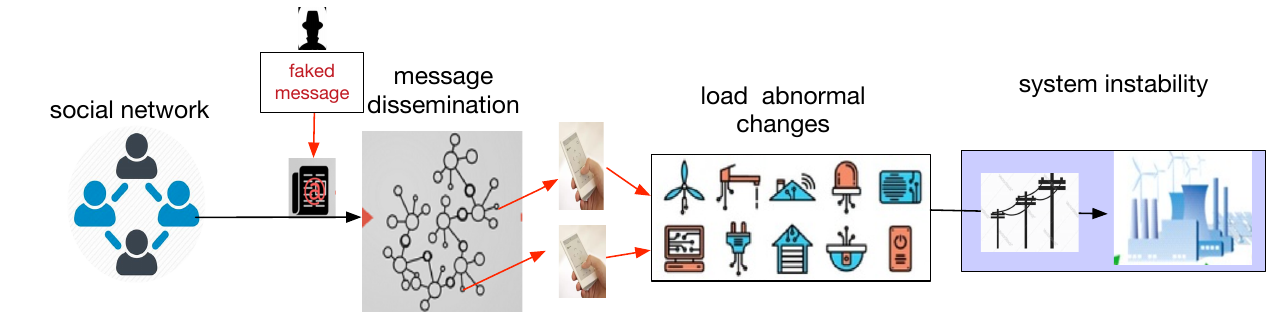
Figure 4. Social-cyber-physical: attack initiated from the social